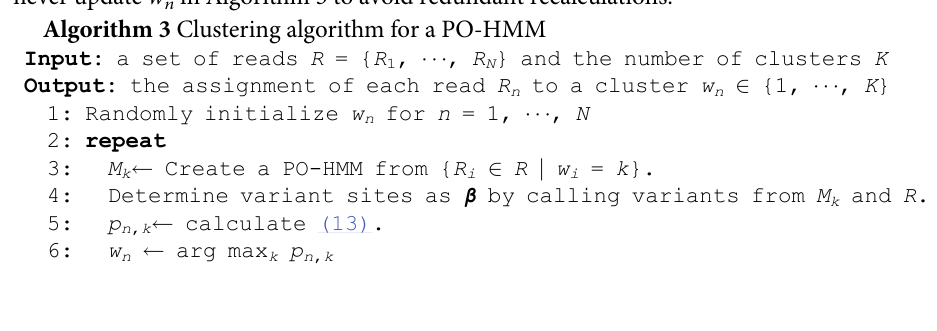
Algorithm 3 Clustering algorithm for a